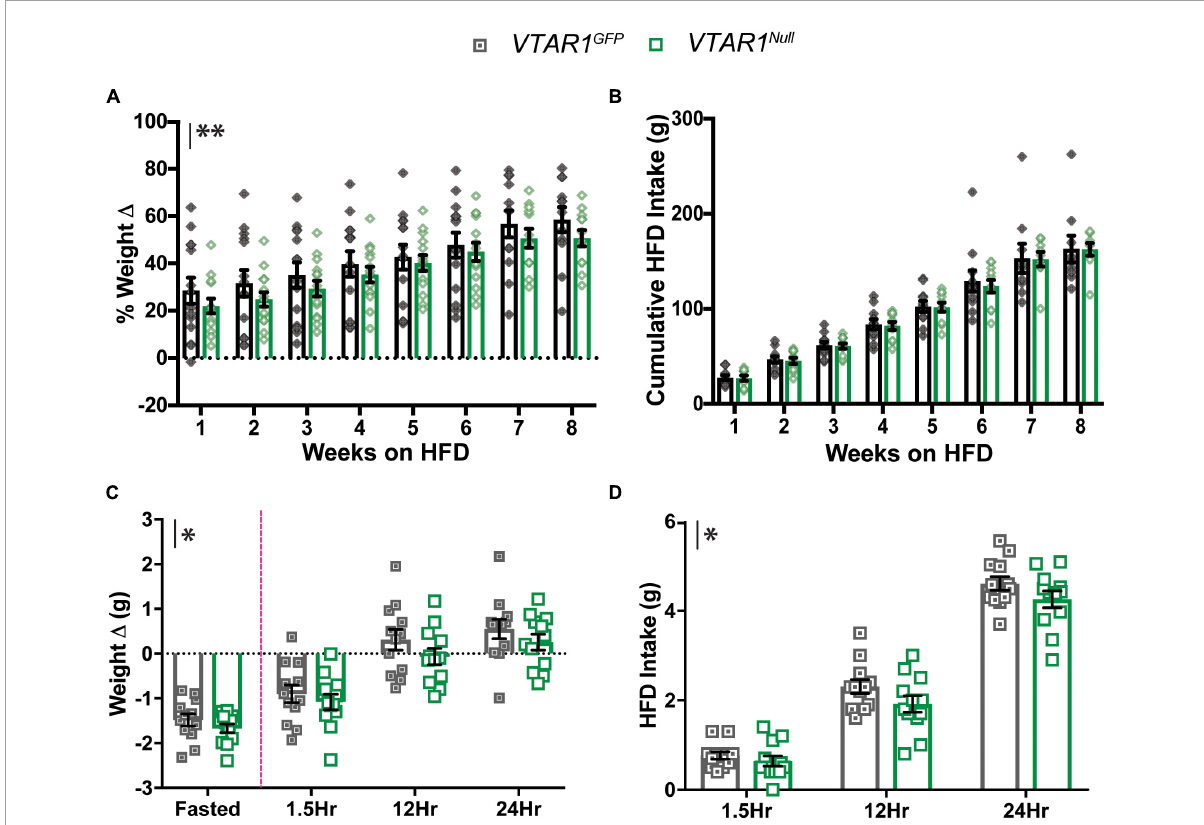
FIGURE9 Adult VTA NtsR1 deletion in obesity decreases body weight and DA-dependent HFD intake. VTAR1 GFP and VTAR1 Null mice were switched to HFD after 8 weeks of normal chow. Body and HFD weight were measured weekly for 8 weeks of HFD. (A) % Weight change on HFD and (B) cumulative HFD Intake. VTAR1 Null mice both have lower body weights on HFD than VTAR1 GFP mice on same diet. However, HFD intake is not significantly different between HFD groups. Data represent mean ± SEM analyzed via ordinary 2Way-ANOVA with Sidak’s correction. n = 12–13. HFD VTAR1 GFP and VTAR1 Null mice were fasted overnight and then re-fed the next day with HFD to assess whether adult NtsR1 deletion decreases DA-mediated HFD intake. Weight was measured ∼ 15 h after mice were fasted and 1.5, 12, and 24 h after HFD was restored. (C) Weight change before and after HFD was restored. (D) HFD intake after chow was restored. VTAR1 Null mice on HFD gained less weight compared to VTAR1 GFP mice, and their HFD intake was overall significantly reduced. Data represent mean ± SEM analyzed via